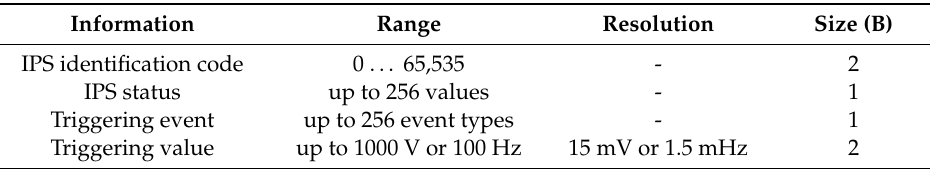
Table 1. Data model of the uplink messages transferred by the IPS to the LoRaWAN infrastructure. IPS: Interface Protection